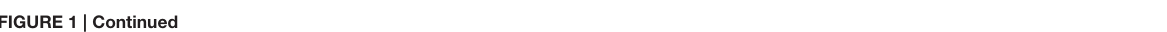
FIGURE 1 | Continued controlling color and ornamentation expression. (B) Light and dark blue transcription factors (TFs) interact directly with the cis -regulatory elements of a key blue pigment synthesis gene, and control the color and the ornamentation of the blue flower, respectively. These TFs are in turn regulated by upstream regulators. (C) In the white-flowered species, pigment synthesis is abolished via inactivation mutations in TFs but the blue pigment synthesis genes (gray) and the upstream regulator for blue color (light blue) remain intact. (D) Introducing the light blue TF (arrowhead) restores blue pigment synthesis in a white-flowered recipient but does not transfer the ornamentation pattern. (E) Possible outcomes of an IGT experiment designed to test the contribution of a candidate locus to the divergence in color. In